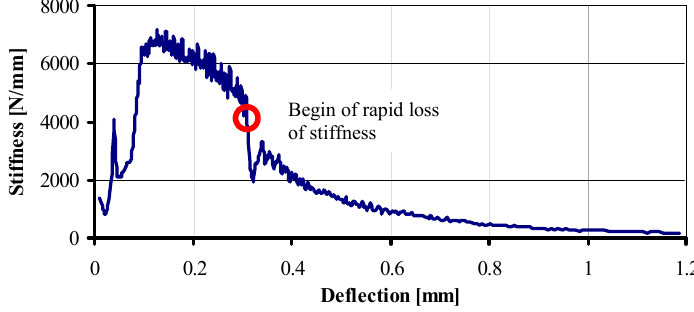
Figure 5: Specimen stiffness of test